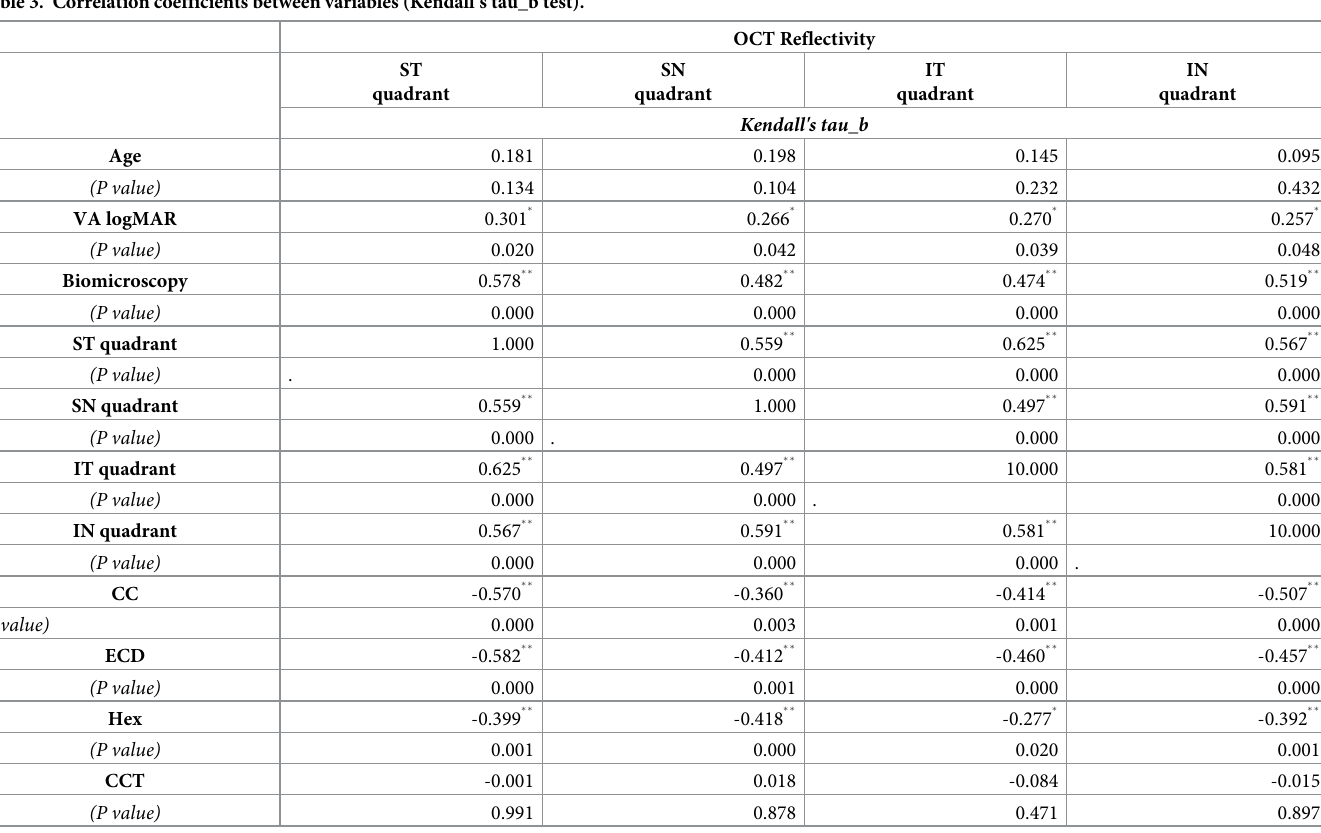
Table 3. Correlation coefficients between variables (Kendall’s tau_b